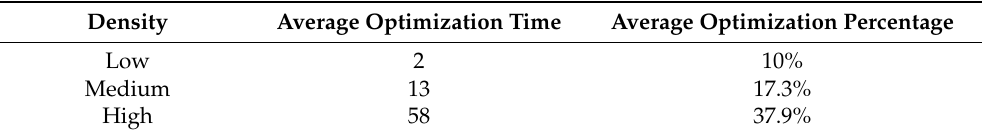
Figure 13. Histogram of Empirical Scheduling vs. Operational Research Model for different density conditions. Table 8. Adjusted experience